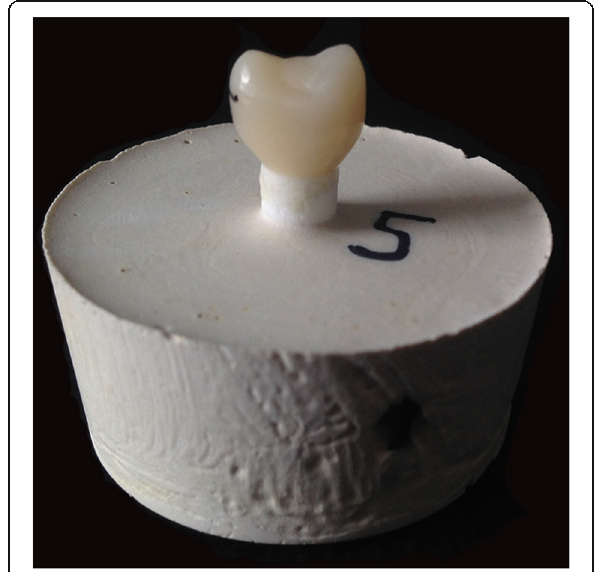
Fig. 1 Luted crown on embedded implant before chewing simulation